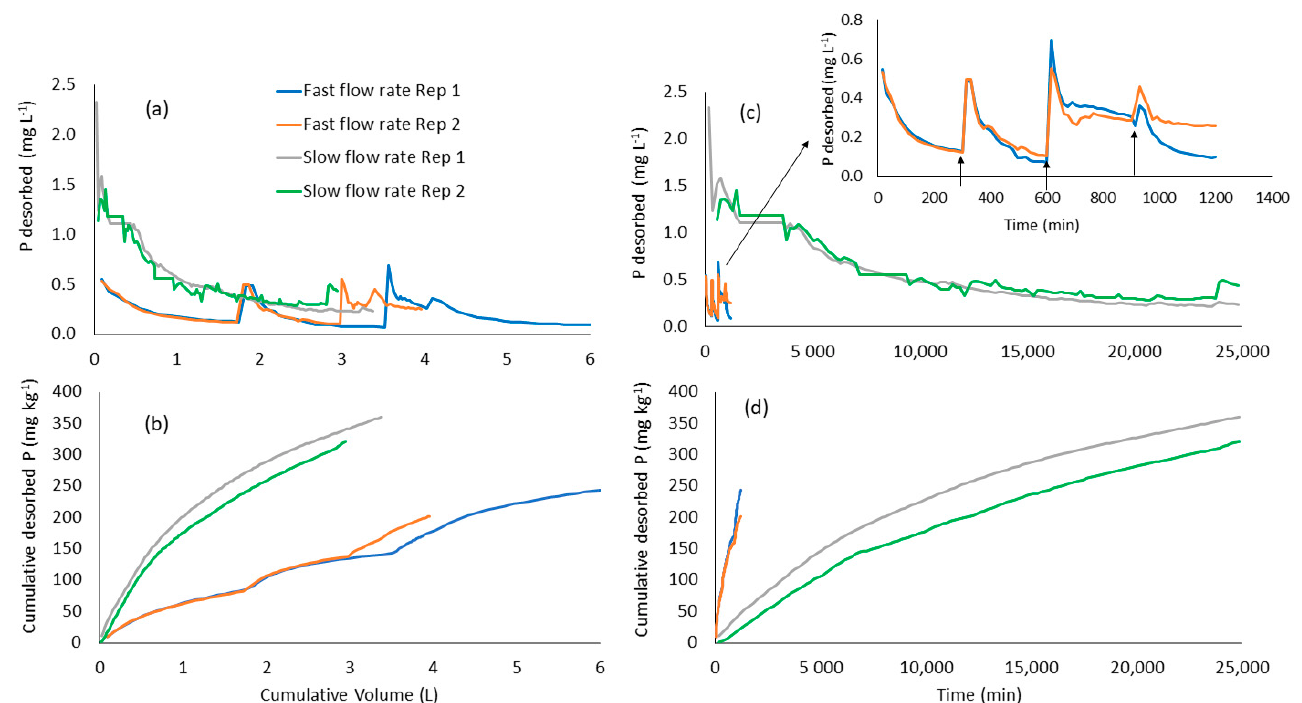
Figure 6. Phosphorus (P) flow-through desorption as a function of cumulative volume ( a , b ) and time ( c , d ), expressed as discrete solution concentrations ( a , c ) and cumulative P release per kg soil ( b , d ) at fast and slow flow rates (25 and 0.5 cm h − 1 , respectively). Time on x -axis is time of flow. Inset in ( c ) is for the fast flow rate; arrows in that figure indicate the points in which a 48 h interruption of no-flow was initiated.